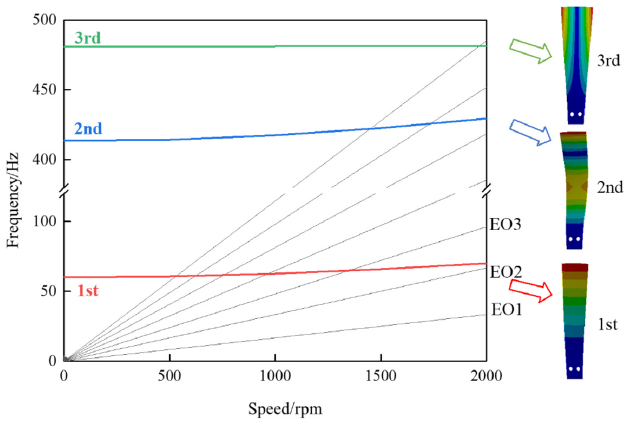
Figure 11. Campbell diagram of modal frequency of model blade.